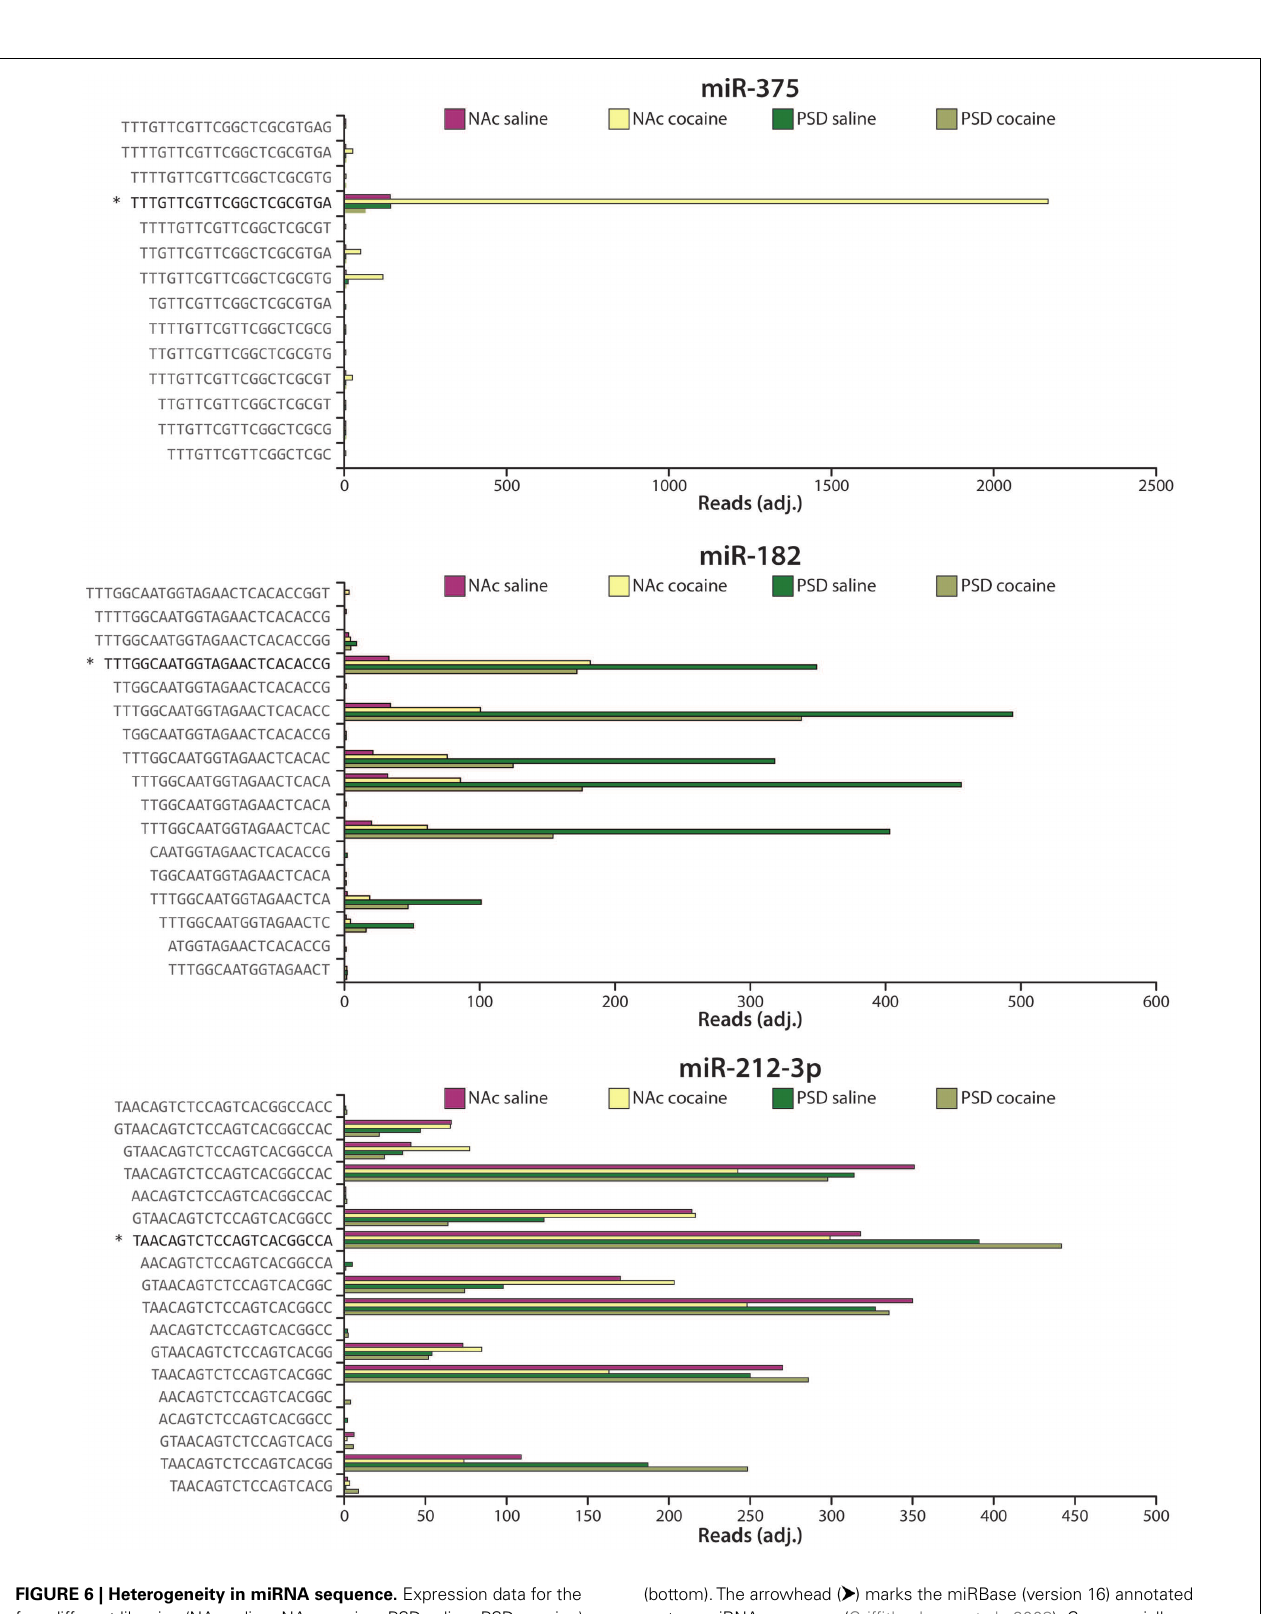
FIGURE 6 | Heterogeneity in miRNA sequence. Expression data for the four different libraries (NAc saline, NAc cocaine, PSD saline, PSD cocaine) are shown as reads (adjusted for equal total reads per sample) for sequences mapping to miR-375 (top), miR-182 (middle), and miR-212-3p